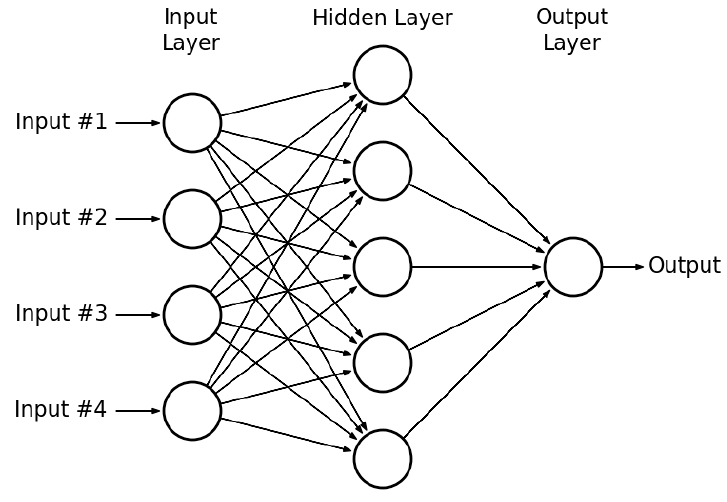
Figure 9. Structure of FFANN.